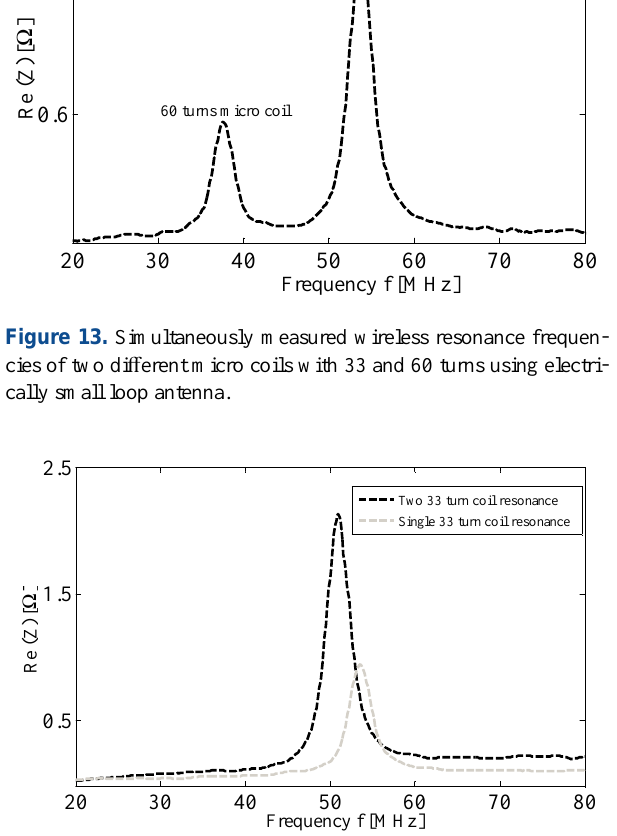
Figure 14. Two 33-turn open-loop micro coil with measured res- onance frequency of 49.93 [MHz] plotted vs single 33-turn micro coil with measured resonance frequency of 51.97 [MHz].